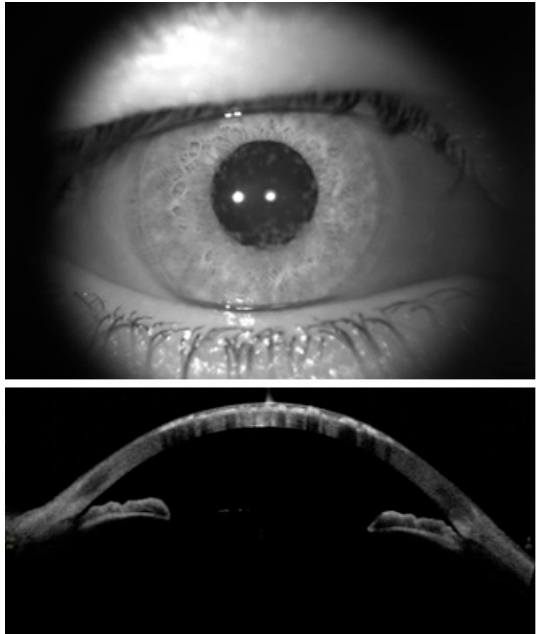
Figure 1. Slit-lamp biomicroscopy (diffuse illumination) (upper image) and anterior segment OCT (AS-OCT) images recorded from a case with GCD in the current study (lower image).